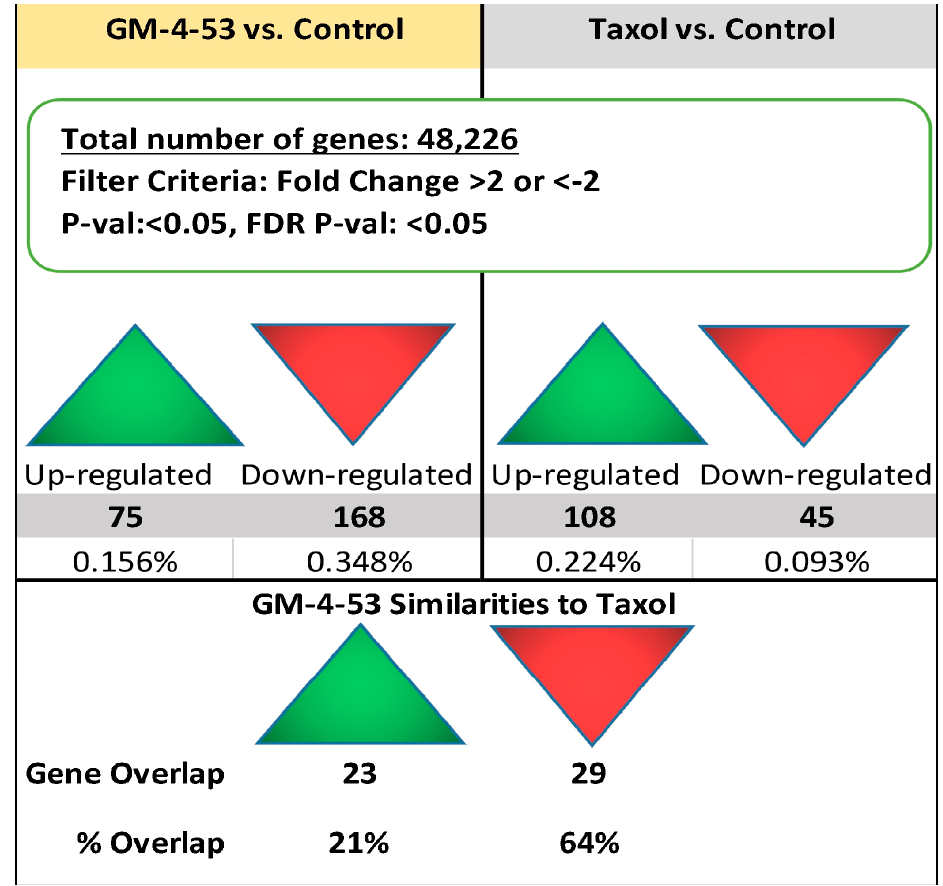
Figure 5. Gene Summary Report. Overall summary of DEGs reflected by whole-transcriptomic analysis in GM-4-53 (5 µg/mL)- or Paclitaxel (1 µg/mL)-treated cells vs. controls after 36 h of incubation in MDA-MB-231 cells; Criteria = FC > 2 or < − 2, p -Value < 0.05 and FDR p -value < 0.05. Information on overlapping DEGs common to paclitaxel and GM-4-53 are also displayed. The gene summary data for each DEG, along with gene symbol, description, fold change, and significance, are presented in Supplementary Table